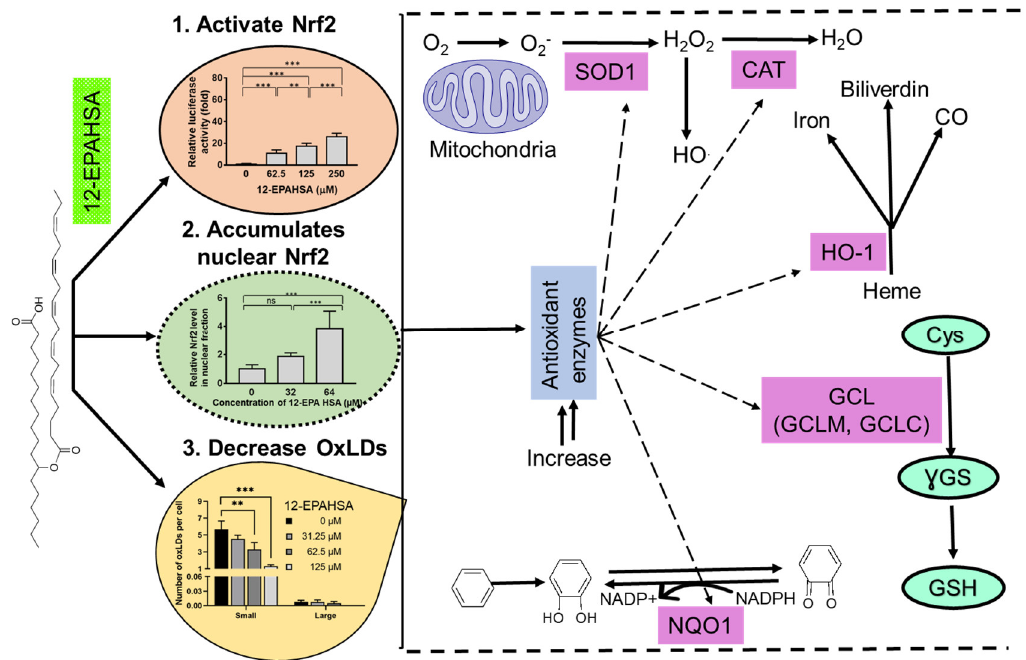
Figure 4. Summary of plausible actions of 12-EPAHSA which could lead to its antioxidant